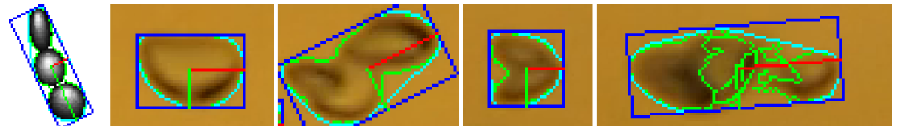
Figure 20. Exemplary bubble detection results. Green shows the detected contours, cyan, the convex hull, and the blue rectangle the final ellipse fitted around the detected contour. From left to right : erroneous detection on synthetic image; correct detection on real image; erroneous detection of two or three bubbles as one on real image; detection of two bubbles as one on real image; detection of two bubbles as one on real image with additional inner